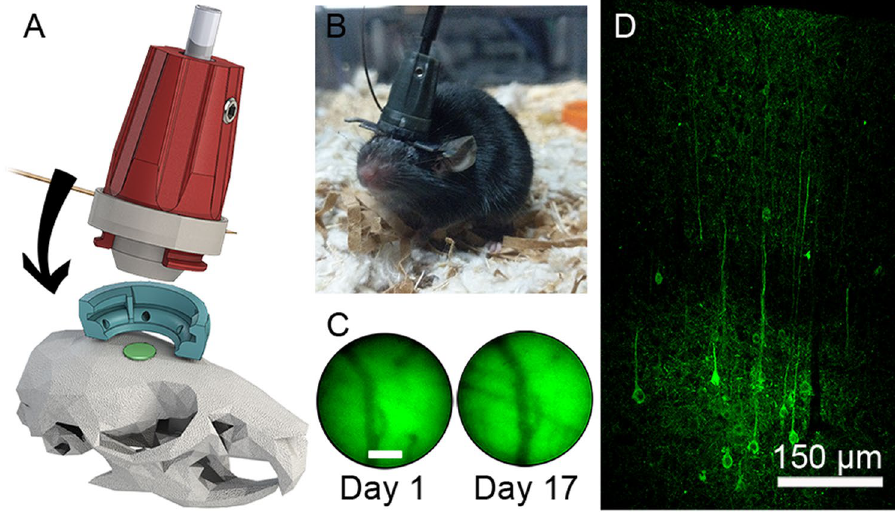
Figure 6. Mouse implant and verification of GCaMP6s expression. ( A ) Attachment mechanism of 2P-FCM onto baseplate attached to the mouse skull. ( B ) Photo of a behaving mouse with 2P-FCM attached. ( C ) Verification of stability of imaging FOV over 17 days, showing the same blood vessels with epifluorescence measured through the FCM. ( D ) Confocal image of the neocortex for a fixed cortical coronal slice of the mouse’s brain 12 weeks post-injection of AAV5 expressing GCaMP6s driven under control of the synapsin